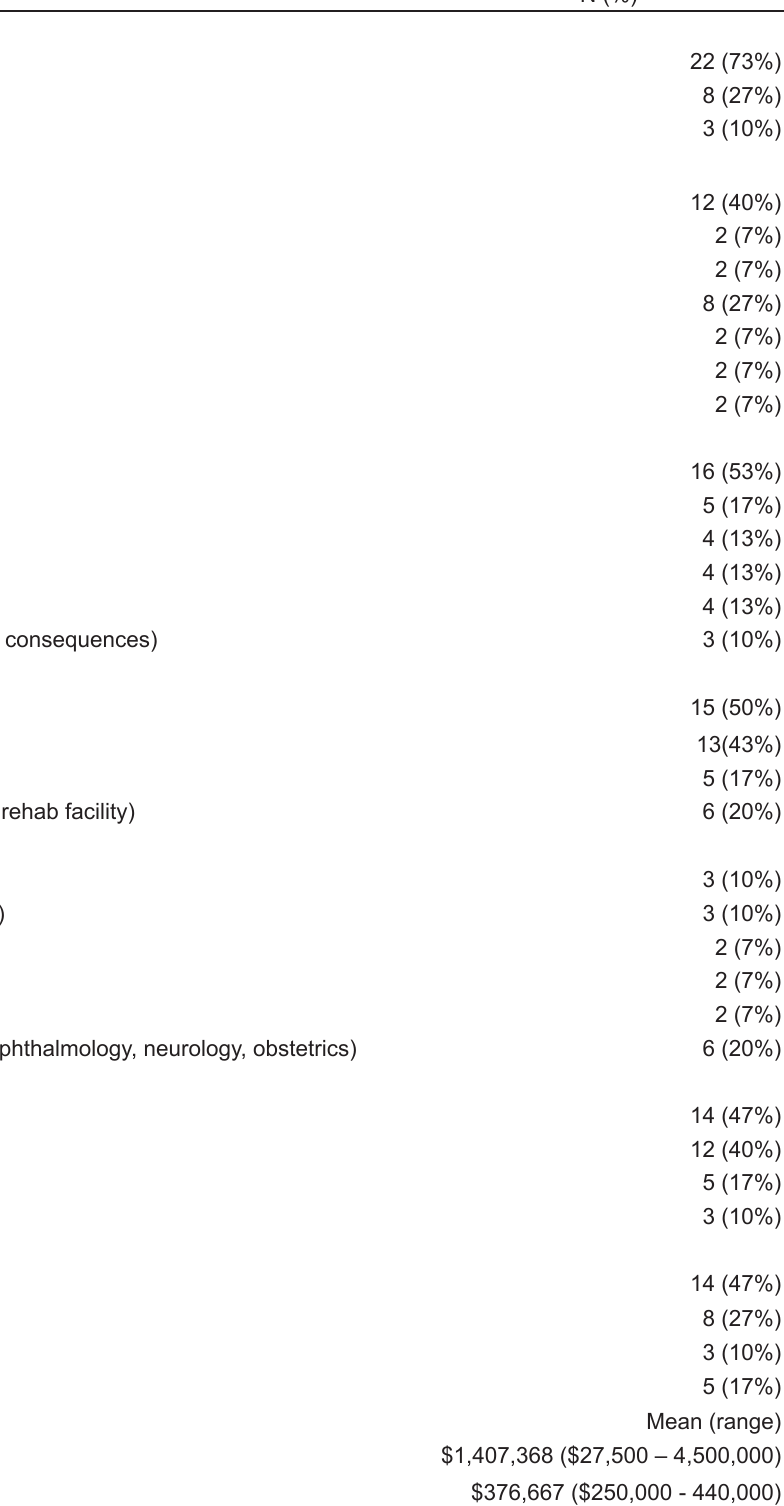
Table 1. Characteristics of cases, patients, and outcomes of 30 lawsuits related to